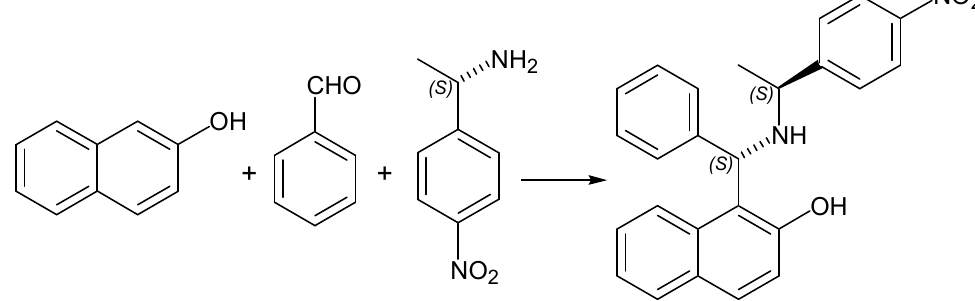
Figure 2. The Betti reaction between 2-naphthol, benzaldehydes and ( S )-1-(4-nitrophenyl)ethylamine. As previously reported, the three components were reacted at 60 ◦ C for two days without the addition of any solvent. A first batch of Betti aminobenzylnaphthol can be obtained by adding small amounts of ethanol; a further batch of it can be obtained by a chromatographic separation (see Experimental). The overall yield was 56%, a value that is similar with those previously reported